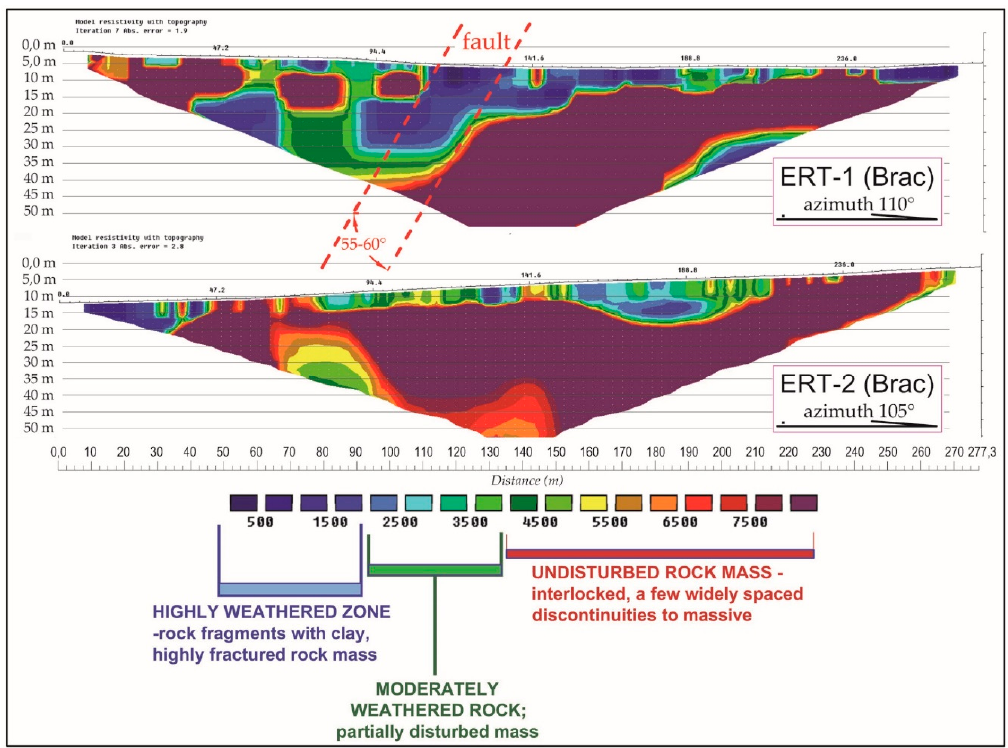
Figure 7. Inverse model resistivity sections of profiles ERT–1 and ERT–2. The resistivity scale is divided according to the rock mass degree of weathering.